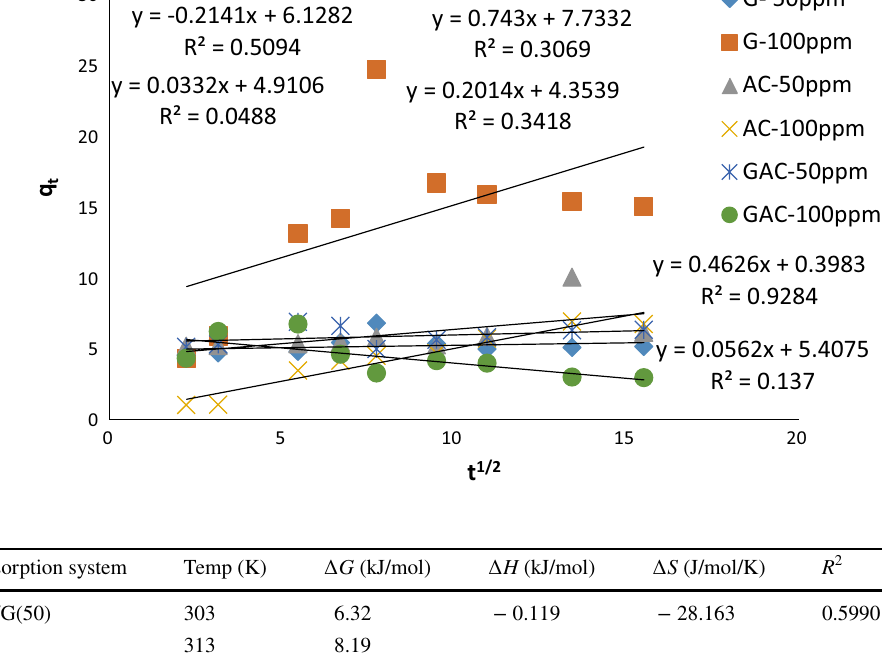
Table 4 Thermodynamic parameters of adsorption of Cr(VI) onto G, AC and G–AC